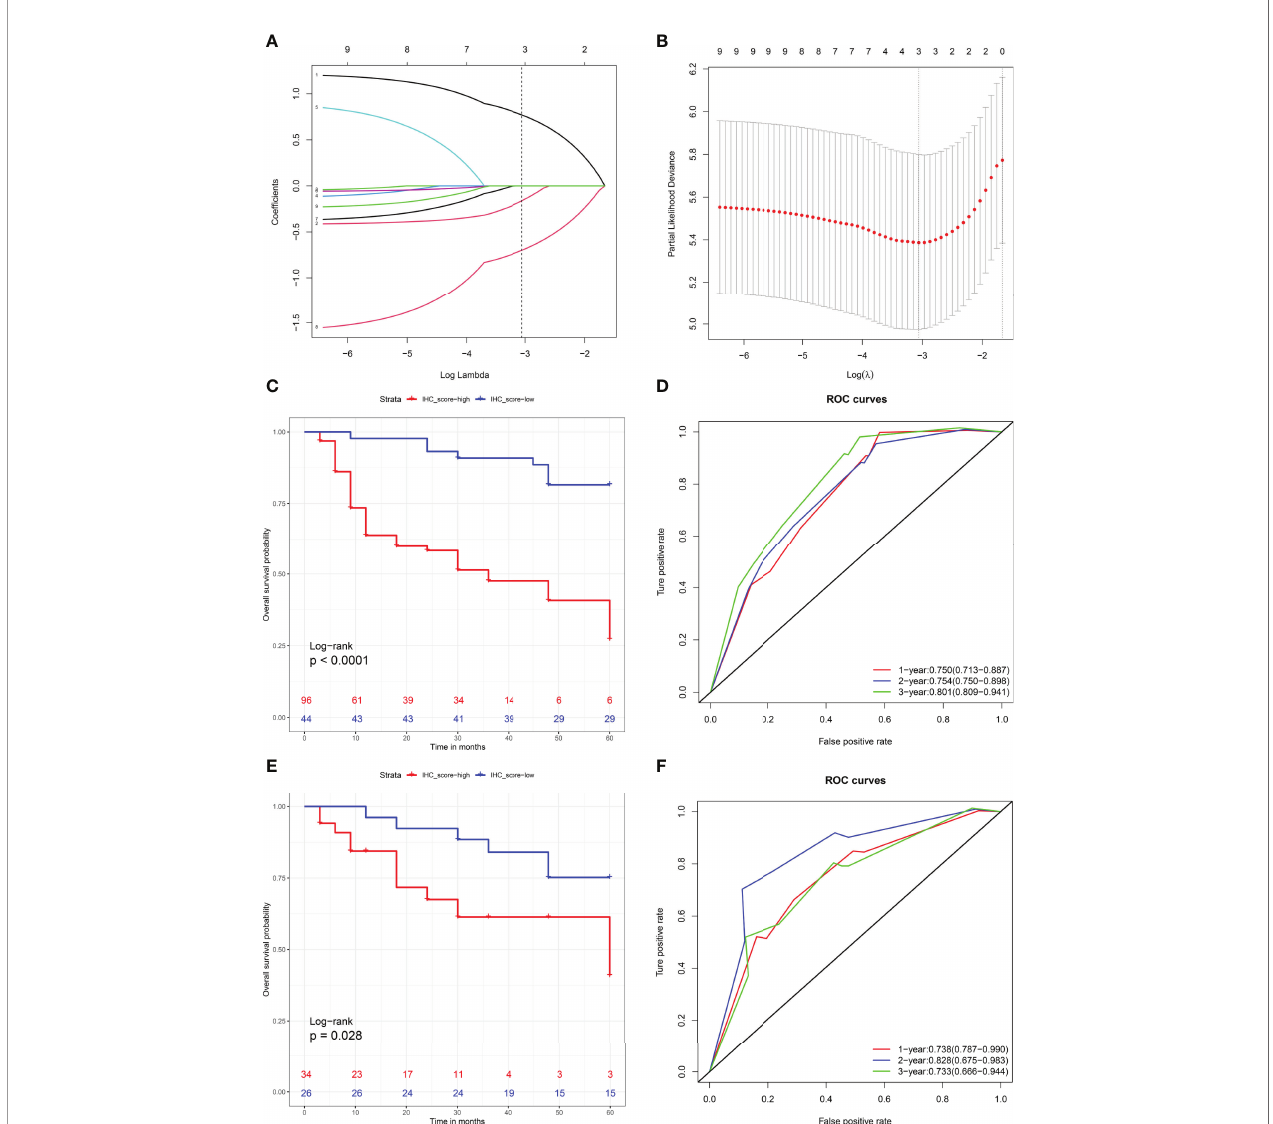
FIGURE 4 | (A) LASSO coefcient pro fl es of the nigh molecules. Number 1-9 respectively represent Ki-67, Her2, P16, P53, Uroplakin III, Microsatellite instability status, Snail, E-Cadherin and PD-L1. (B) Partial likelihood deviance for LASSO coef fi cient pro fi les by in 10-times cross-validation. Vertical black dotted line represent an optimal values tuning parameter ( l ). (C, D) Recurrence-free survival analysis with Kaplan-Meier method for patients divided by IHCscore in the training (C) and validation sets (D) . (E, F) ROC with AUC of recurrence-free survival at 1-, 2-, and 3-year predicted by IHCscore in the training (E) and validation (F)